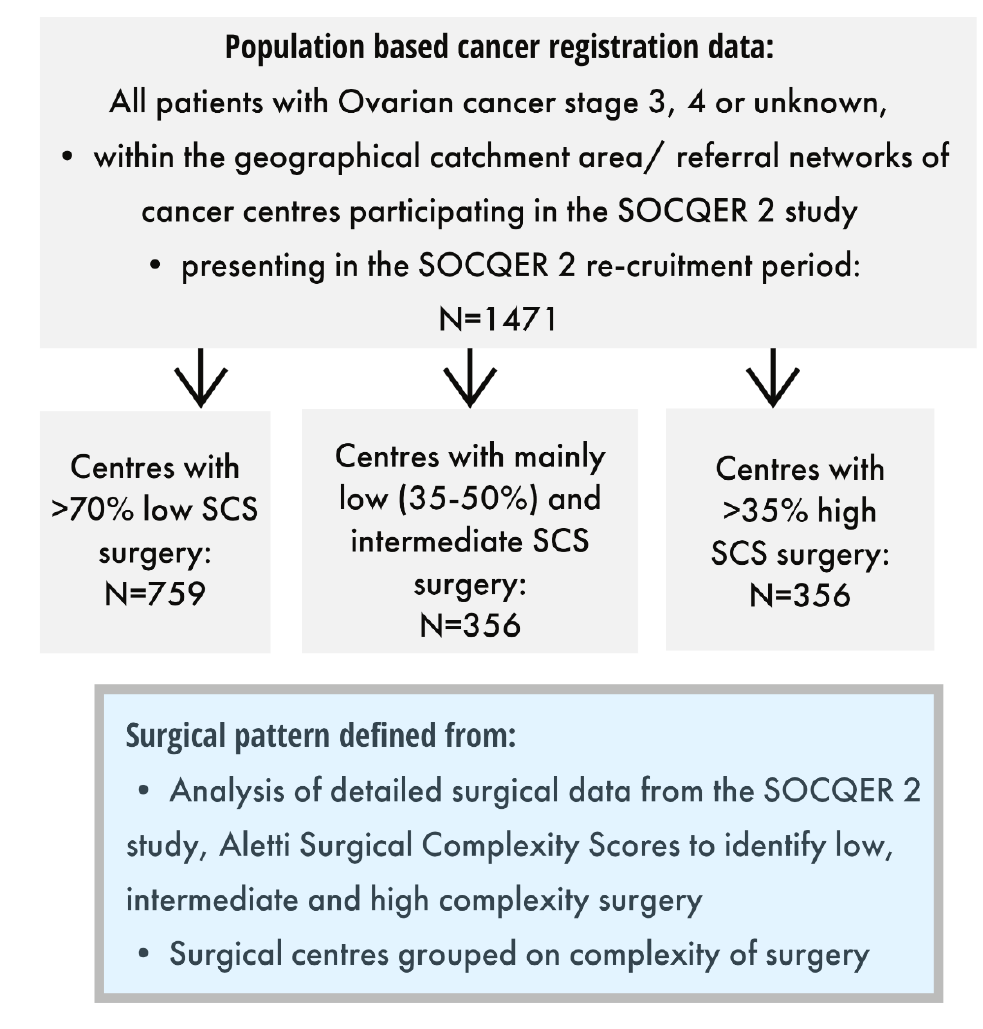
Figure 1. Included patients and surgical centre categories.